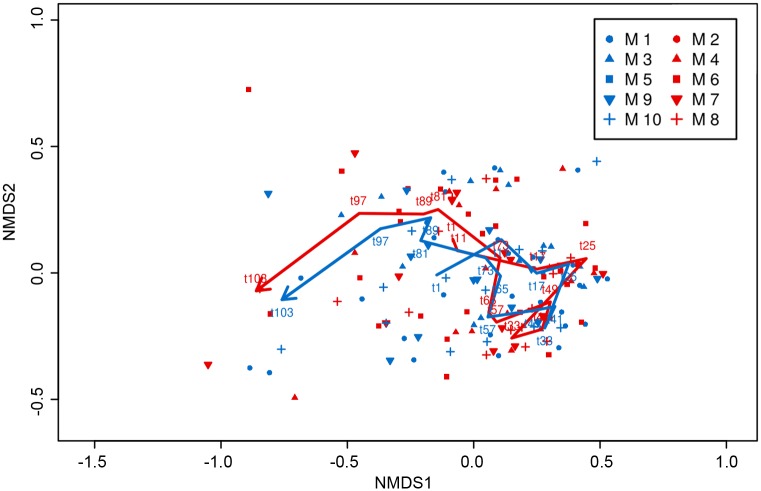
Non-metric Multidimensional Scaling analysis (NMDS) of the mesozooplankton community (stress value = 0.17).Colour code: red = treatment (~760 μatm pCO2), blue = control (ambient conditions). Sampling days represented as t-day; lines represent patterns. The underlying data implemented in the analysis are shown in Fig 1.